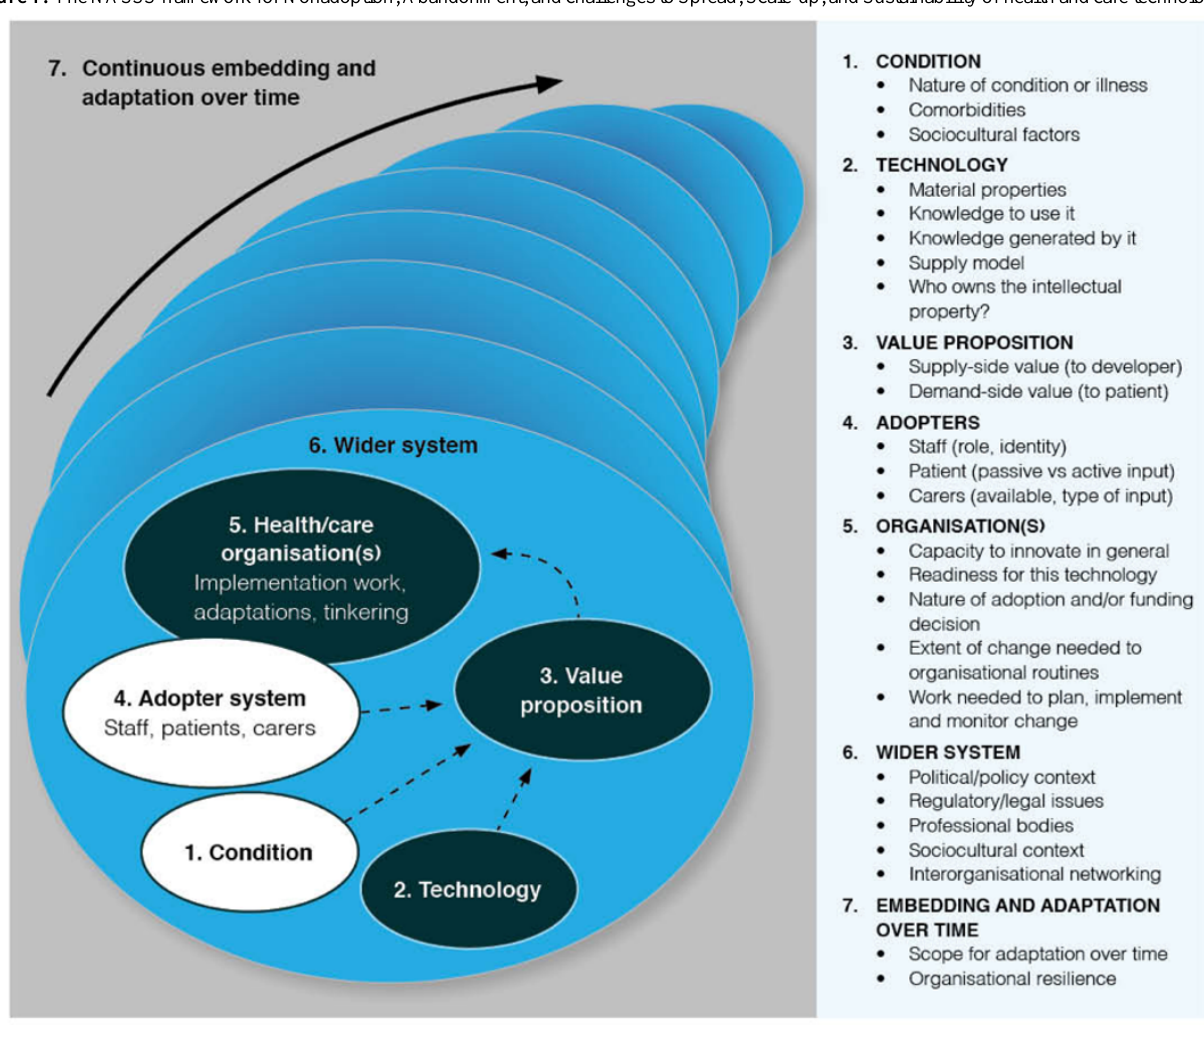
Figure 1. The NASSS framework for Nonadoption, Abandonment, and challenges to Spread, Scale-up, and Sustainability of health and care